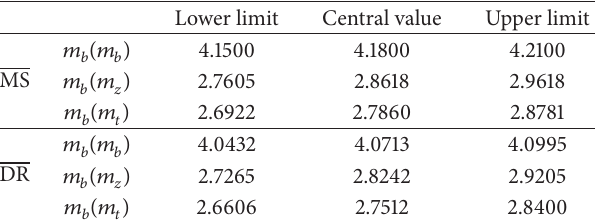
Table 3: 𝑚 𝑏 in MS and DR schemes. Lower limit Central value Upper